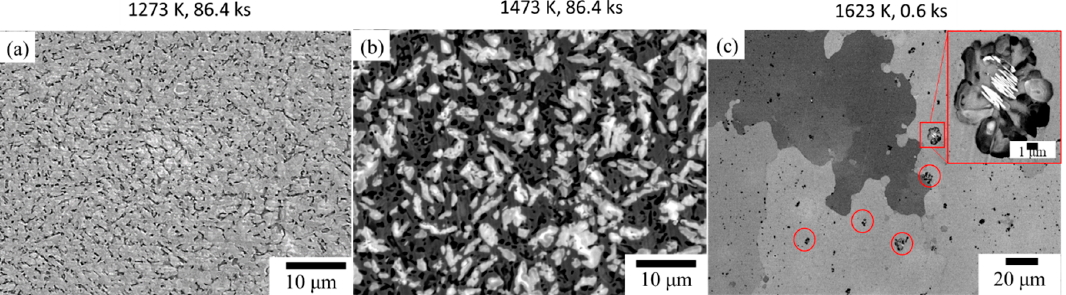
Figure 9. BSE image of the TiNbZrHfTa RHEA fabricated by the hydride process after heat treatment at; ( a ) 1273 K for 86.4 ks, ( b ) 1473 K for 86.4 ks, and ( c ) 1623 K for 0.6 ks.